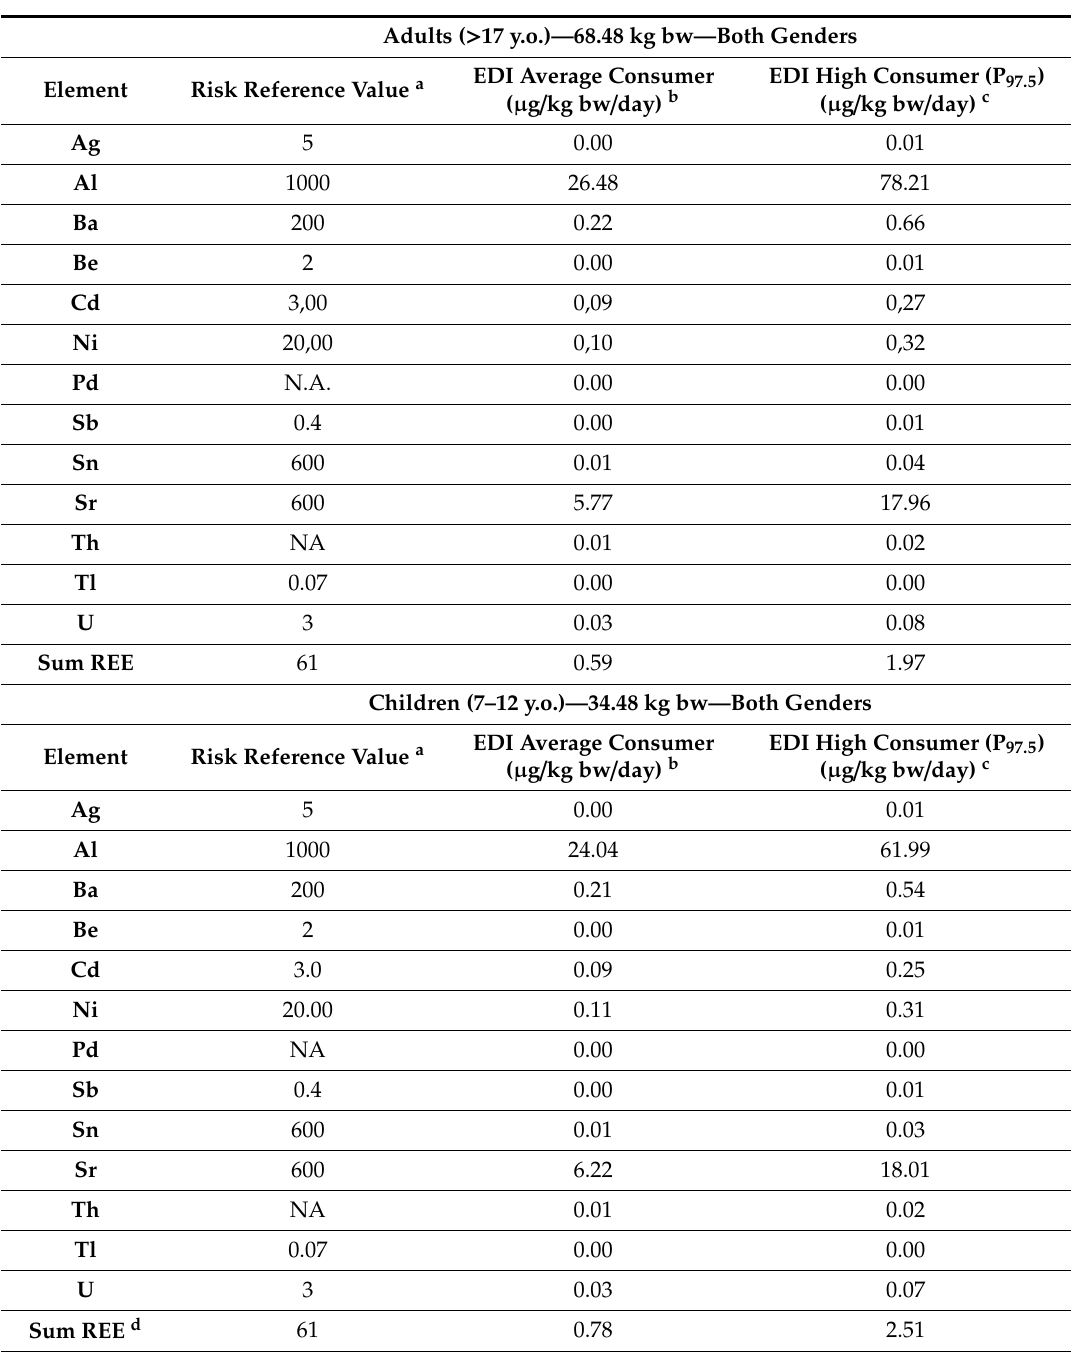
Table 6. Estimated daily intake of other toxic or potentially toxic elements through the consumption of mussels in adults and